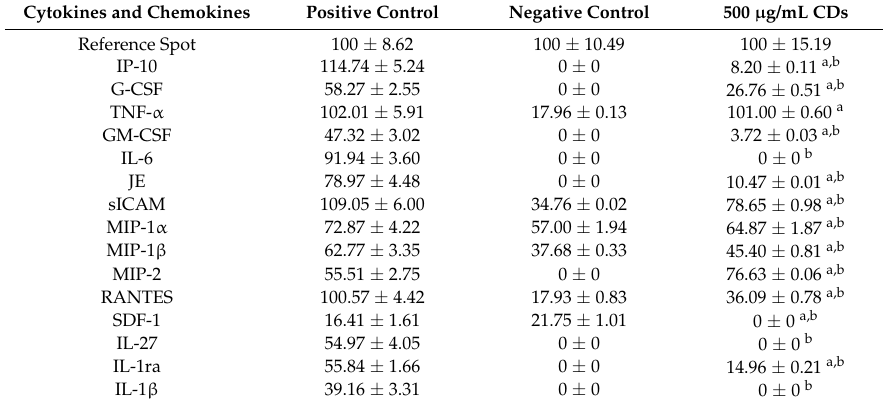
Table 1. Quantification of cytokines and chemokines secreted by RAW 264.7 cultures not stimulated with LPS after treatment with medium only, medium containing LPS or medium containing 500 μ g/mL carbon dots (CDs). Membranes subjected to chromogenic exposure. Data is represented as mean ± SD. Significance indicated by a CD at 500 μ g/mL significantly different compared to negative control ( p < 0.001), b CD at 500 μ g/mL significantly different compared to the positive control ( p < 0.001).